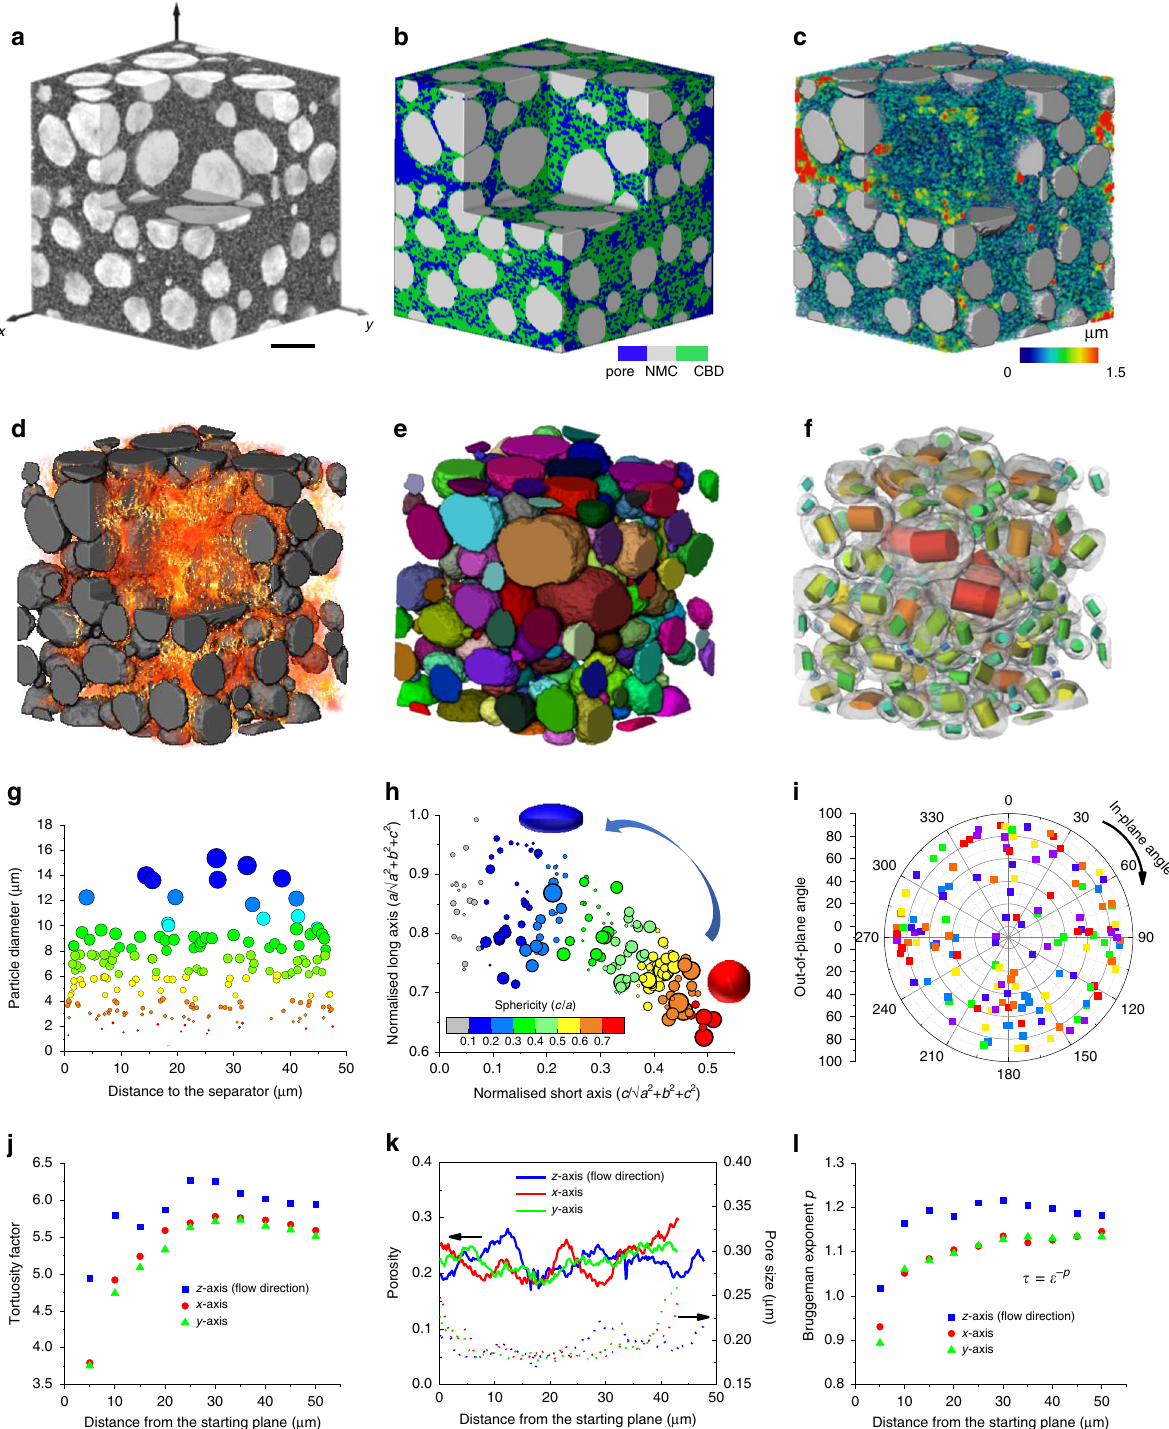
Fig. 2 3D characterisation of the NMC cathode based on X-ray CT data. a Reconstructed volume of the electrode with different phases represented by greyscale values (white: NMC active material; dark grey: CBD; black: pore). The corner is cut to show the internal morphology; b segmented three phases; c colour-coded pore phase according to its size, shown with NMC particles; d Li + ion diffusive fl ux map in the pore phase used for effective mass transport estimation; e identi fi cation of individual NMC particles; f visualisation of the shape, orientation and size of each individual particle; g resultant particle size distribution as a function of distance from the separator. Symbols are colour-coded according to the particle size; h sphericity distribution of the NMC particles. The size of the scatter points represents the size of the particles and the colour codes represent the sphericities; i orientation map of the individual particles, with the azimuthal angles and radial distance representing the in-plane and out-of-plane orientations; j tortuosity factor obtained based on the diffusive fl ux from ( d ) in three directions; k slice-by-slice variation of porosity and pore size in three orthogonal directions; l Bruggeman exponents as a function of the fraction of the electrode thickness in three orthogonal directions. The scale bar in ( a ) represents 10 μ